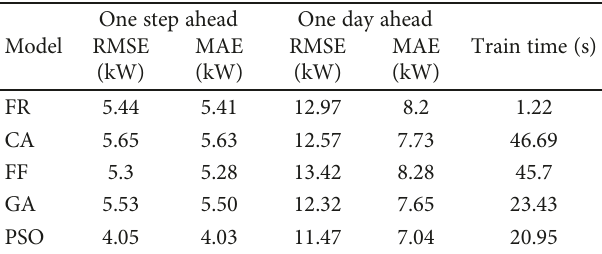
Table 2: Comparison of prediction interval forecast for solar